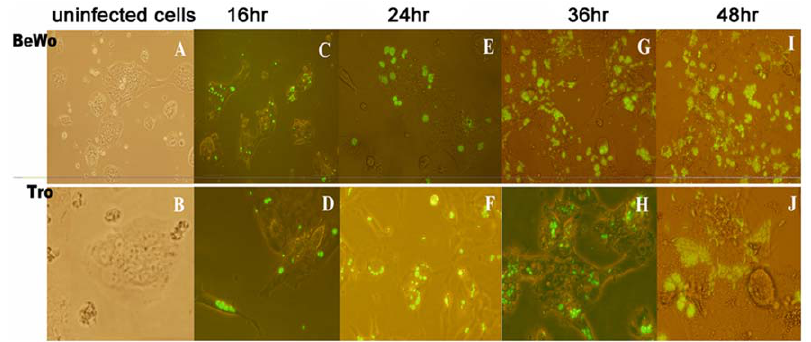
Figure 1. Fluorescence analysis of infection of BeWo cells and trophoblasts with YFP- T.gondii . Infected and uninfected (A) BeWo cells and (B) trophoblasts were observed under fluorescence microscope. The infection with T. gondii expressing yellow fluorescent protein in BeWo and trophoblasts were observed by fluorescence microscopy at (C, D) 16 hr, (E, F) 24 hr, (G, H) 36 hr, and (I, J) 48 hr. At 16 hr, coupled or ternate tachyzoites were observed inside the cells. Tachyzoites arranged in a chrysanthemum shape were observed at 24 hr. Broken cells and scattered tachyzoites were observed at 48 hr.